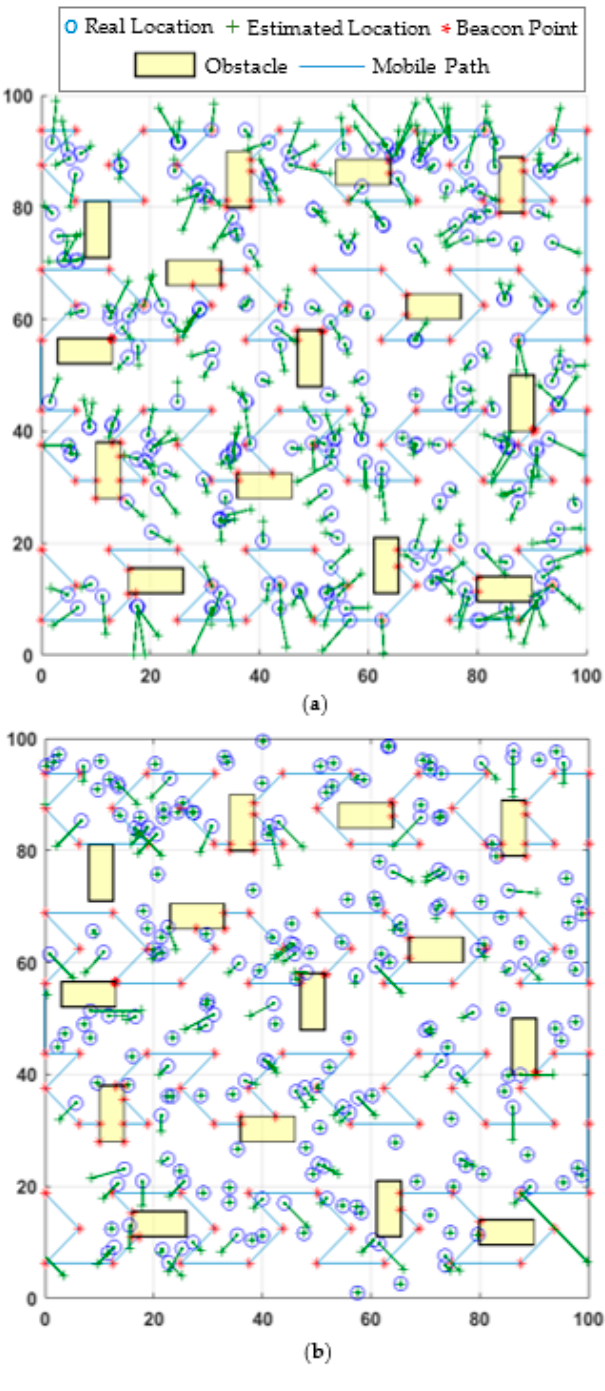
Figure 10. The proposed mobile path’s obstacle-handling trajectory and estimated locations of the nodes distribution in ( a ) WCL, and ( b ) APT. nodes distribution in ( a ) WCL, and ( b )